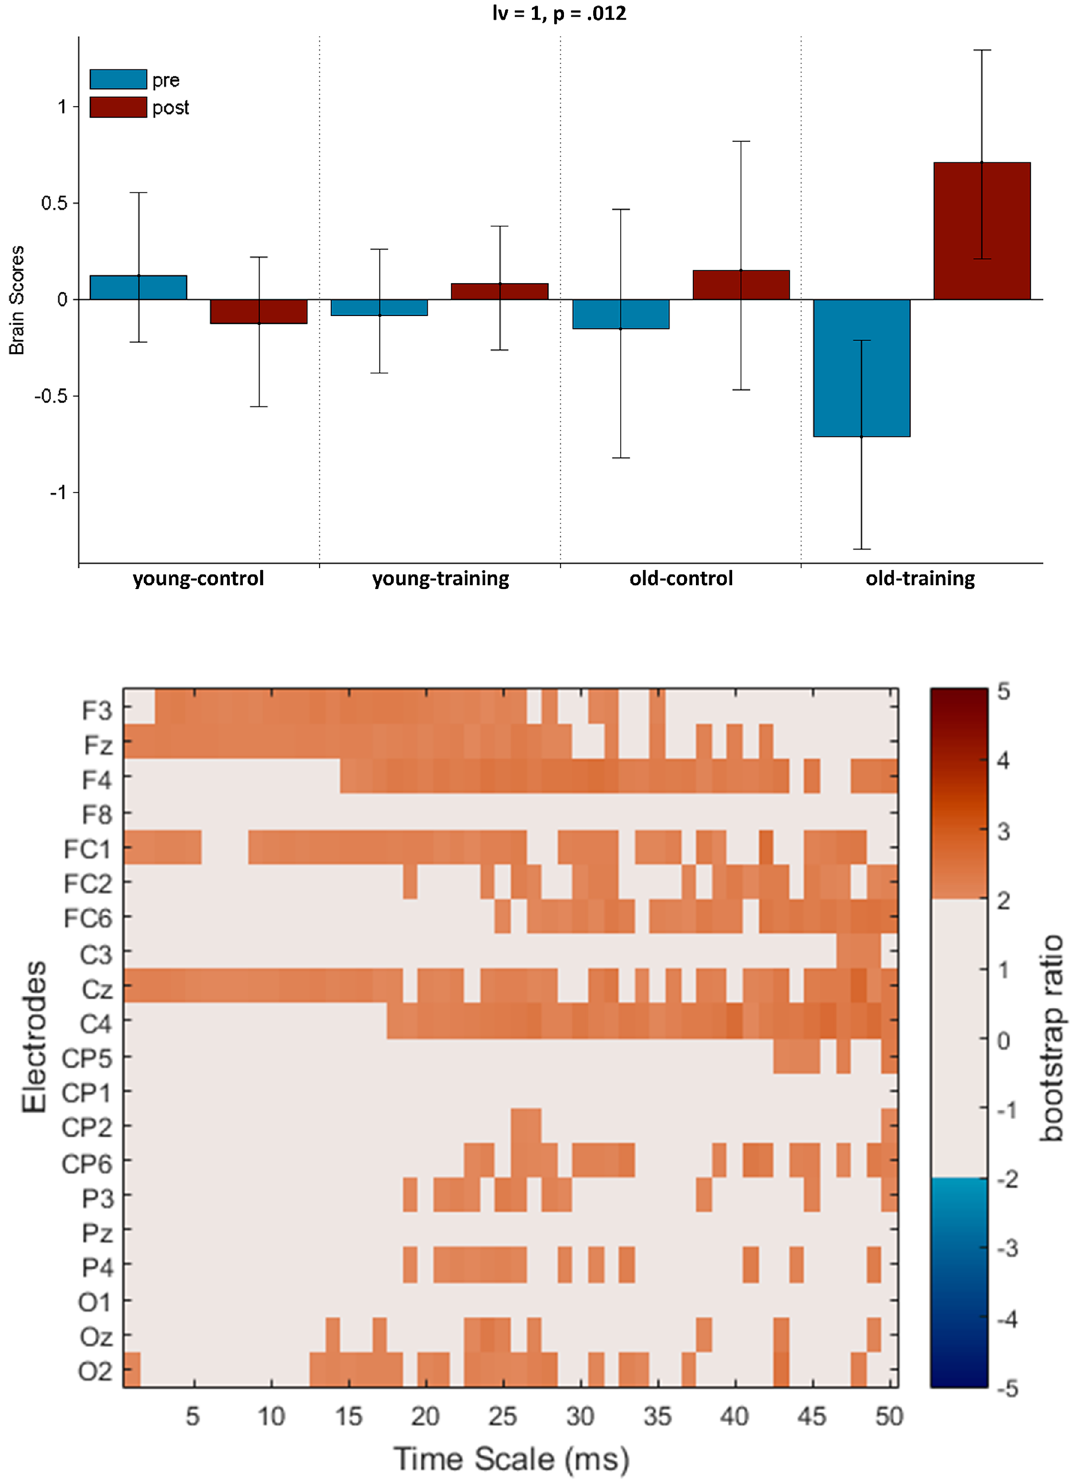
Figure 7. PLS analysis results for the group by condition effect (pre- vs. post-training resting state) on MSE. (Top) The bar graph depicts the contrast between experimental groups across age and training conditions that was significantly expressed across electrodes and timescales as determined by permutation tests, with error bars denoting 95% confidence intervals. (Bottom) The bootstrap ratio map illustrates the electrodes and timescales at which the contrast displayed in the bar graphs was most stable. Values represent the ratio of the individual electrode weights and the bootstrap-derived standard error (roughly z scores, thresholded at 2.0 which corresponds approximately to p < 0.05). Positive values are plotted in warm colours and indicate timescales and electrodes showing increases from pre- to post-training in resting state MSE. Negative values are plotted in cool colours and denote decreases from pre- to post-training in resting state